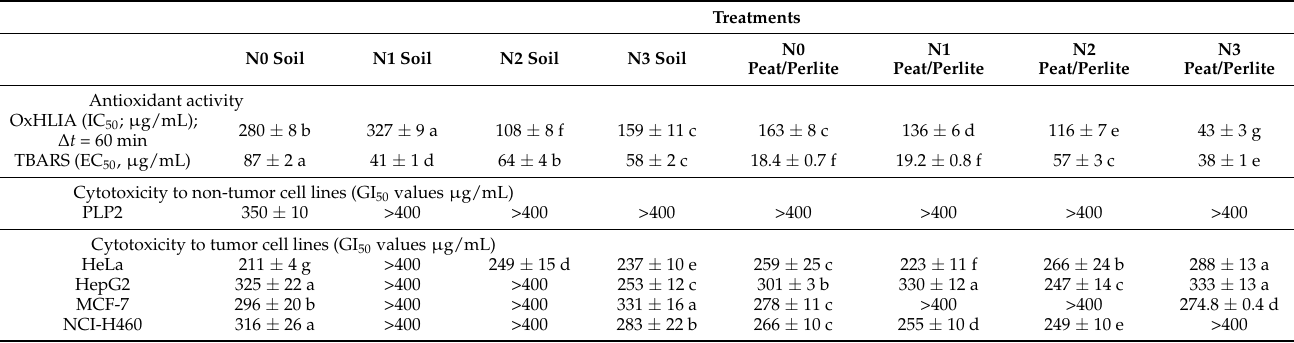
EC 50 : extract concentration corresponding to a 50% of antioxidant activity. Trolox EC 50 values: 23 µ g/mL (thiobarbituric acid reactive substances (TBARS) inhibition) and 19.6 µ g/mL (oxidative hemolysis inhibition assay (OxHLIA) ∆ t = 60 min). GI 50 values correspond to the sample concentration responsible for 50% inhibition of growth in tumor cells or in a primary culture of liver cells-PLP2. GI 50 values for ellipticine (positive control): 1.2 µ g/mL (MCF-7), 1.0 µ g/mL (NCI-H460), 0.91 µ g/mL (HeLa), 1.1 µ g/mL (HepG2), and 2.3 µ